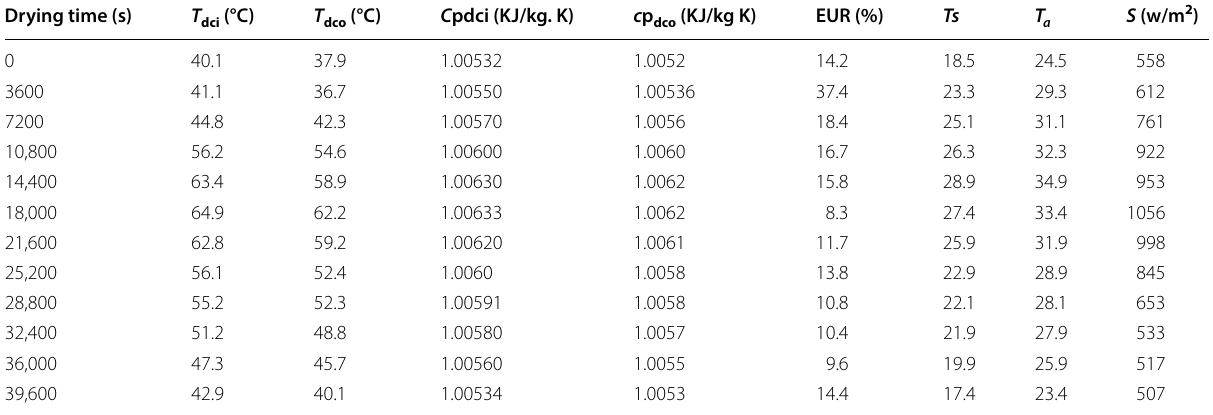
Table 22 Result energy analysis onion 4th